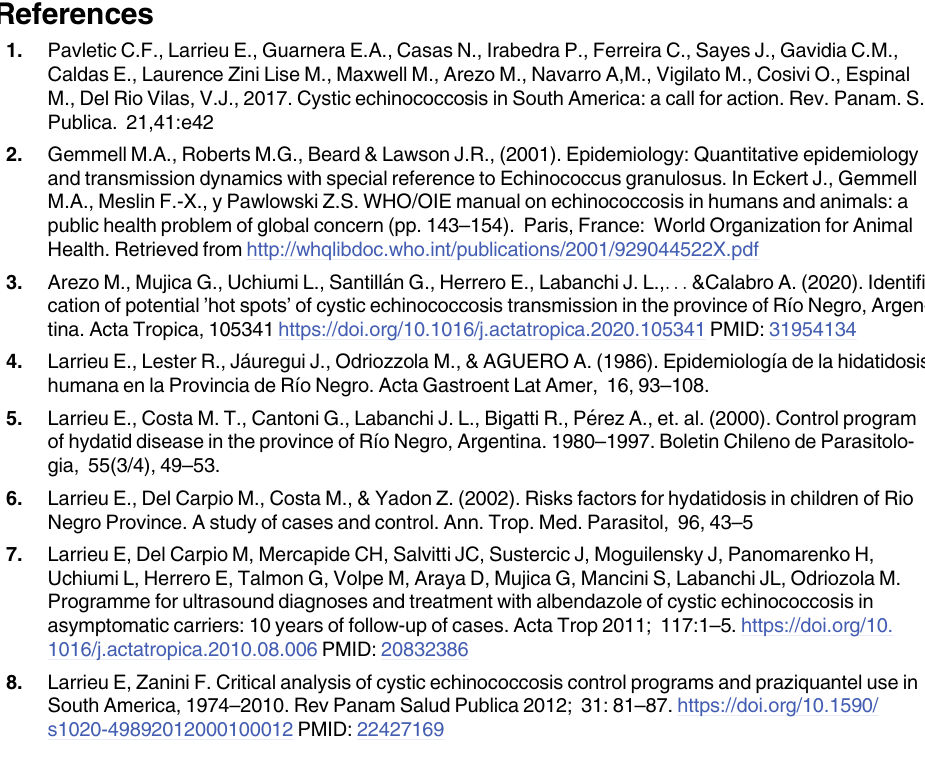
S6 Fig. Model 1.1a - Probability of Exceedance—Surveillance